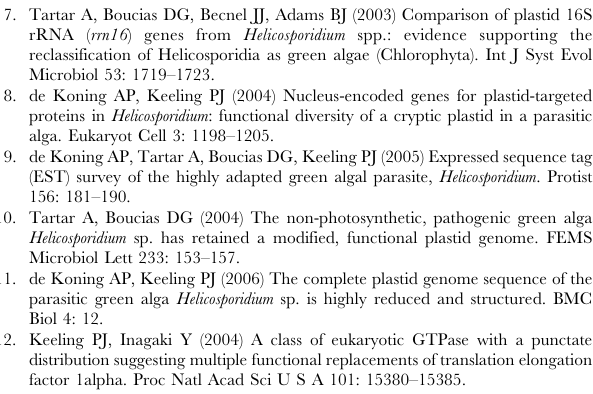
Table S1 Gene repertoires of Helicosporidium and other chlor-